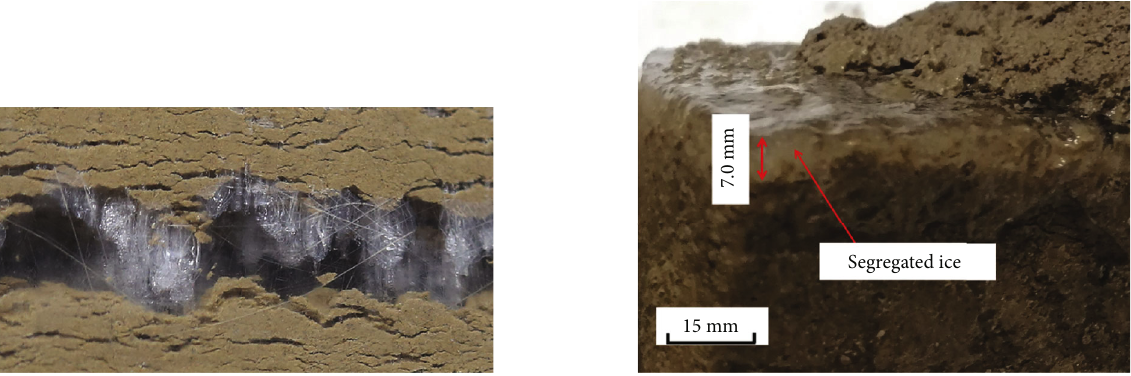
Figure 16: The T4 soil column segregated ice